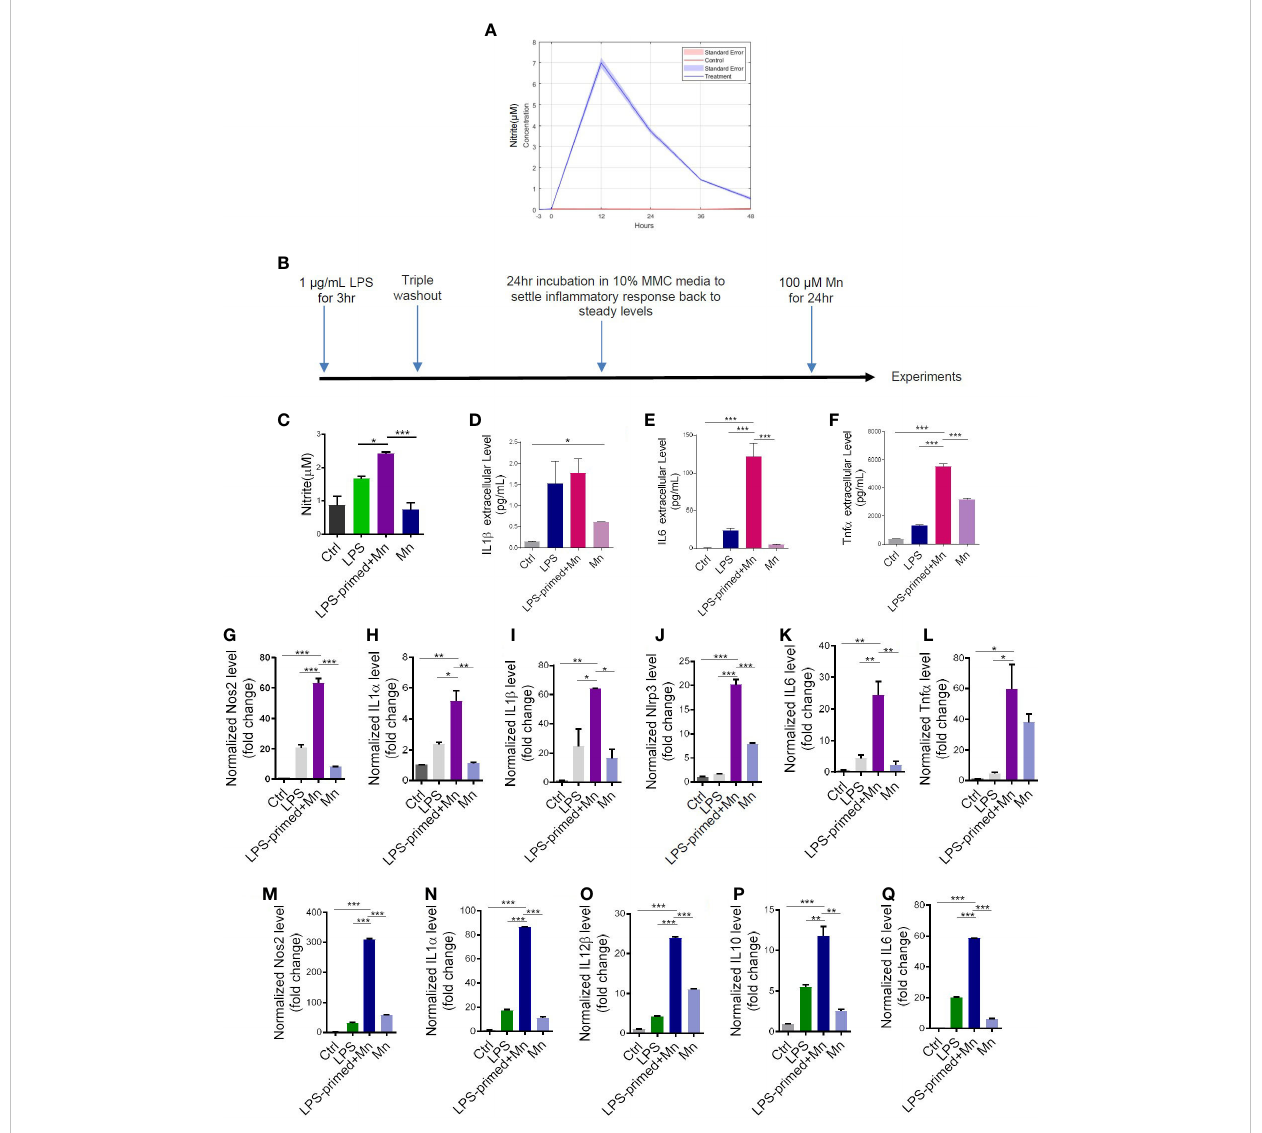
FIGURE 1 Heightened in fl ammatory responses in trained immunity. (A) LPS-induced time response experiment in mouse microglial cells (MMCs) via Griess assay. Data are means ±SEM of two individual experiments performed in four replicates. Light blue area denotes SEM. (C) Nitric oxide release from LPS- and Mn-treated, primed MMC via Griess assay (n=8-9), following the treatment paradigm in (B) . LPS+Mn denotes the treatment with LPS for 3 h, a 24-hour recovery, and then Mn for 24 h. (D – F) Luminex bead-based cytokine assays (n=3) of pro-in fl ammatory cytokine release following the treatment paradigm in (B) . (G – L) RT-qPCR analysis of Nos2 , IL-1 a , IL-1 b , NLRP3 , IL-6 , and Tnf a in Mn-exposed, LPS-primed PMG cells following the treatment paradigm in (B) . Two individual experiments (n=2) were performed. (M – Q) RT-qPCR analysis of Nos2 , IL-1 a , IL-12 b , IL-10 , and IL-6